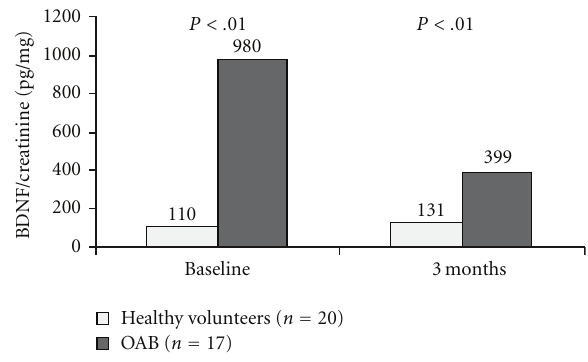
Figure 2: BDNF/creatinine in the urine of female healthy volun- teers and OAB patients, at baseline and after 3 months of lifestyle